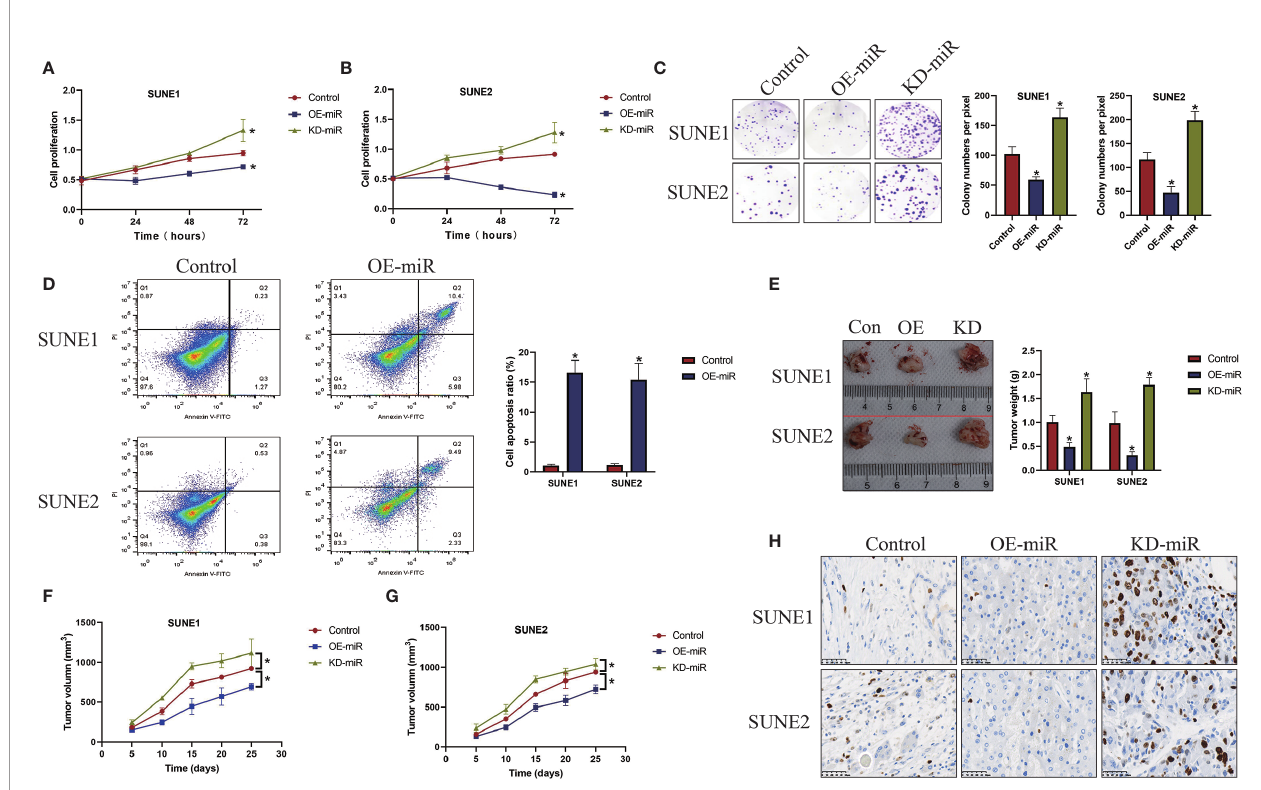
FIGURE 2 | MicroRNA-338-5p inhibited NPC cell proliferation and viability in vitro and in vivo . (A, B) The NPC cells (SUNE1 and SUNE2) were pre-transfected with different vectors, and were cultured for 0, 24, 48, and 72 h, respectively. The CCK-8 assay was performed to evaluate cell proliferation abilities. (C) Colony formation assay was used to determine colonies formation abilities in NPC. (D) The NPC cells were stained with Annexin V-FITC and PI, and cell apoptosis ratio was measured by fl ow cytometer (FCM). The xenograft tumor-bearing mice models were established, and (E) tumor weight and (F, G) volume were measured and documented. (H) Immunohistochemistry (IHC) assay was performed to examine the localization and expression levels of Ki67 protein in mice tumor tissues. Each experiment repeated at least three times, and * P <